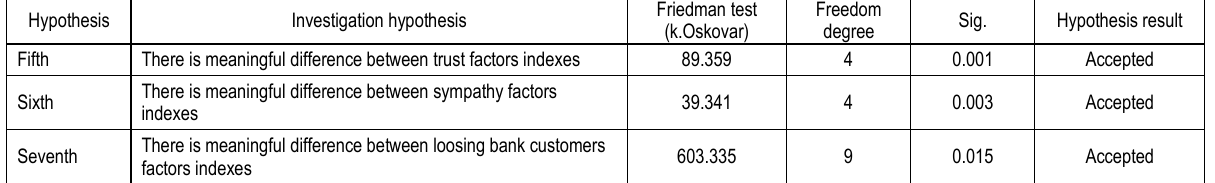
Table 22 (cont.). Results of significance between hypothesis and each of investigation hypothesis